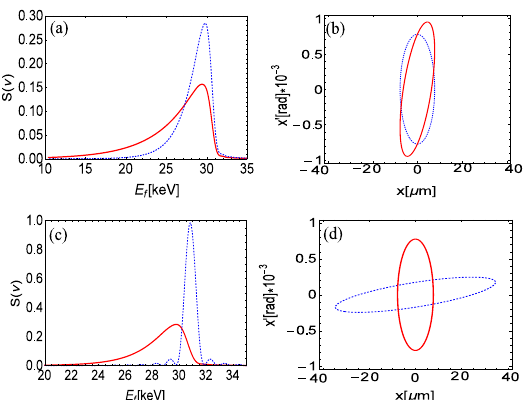
Figure 11. Spectral line of the scattered photons vs. energy (keV) (on the left) and the Courant-Snyder ellipse, respectively, (on the right) for the e-beam and laser parameters as Figure 10 with ε n , x , y = 3 × 10 − 7 mrad and σ ε = 0. Different combination of Twiss parameters has been provided; ( a , b ) β T ( x , y ) = 0.01 m , α T ( x , y ) = 0.707 (continuous), β T ( x , y ) = 0.01 m , α T ( x , y ) = 0 (dot); ( c , d ) β T ( x , y ) = 0.01 m , α T ( x , y ) = 0, (continuous), β T ( x , y ) = 0.2 m , α T ( x , y ) = 1